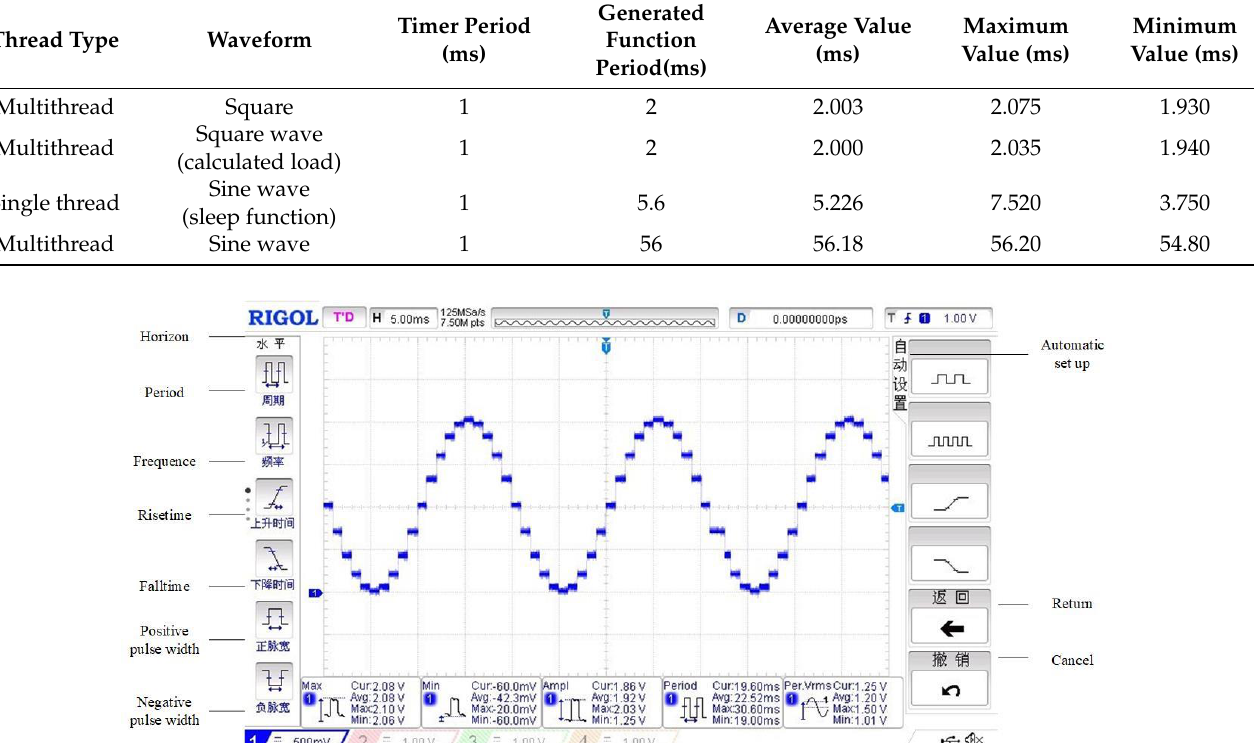
Table 2. Real-time test of the Linux system with the real-time kernel.